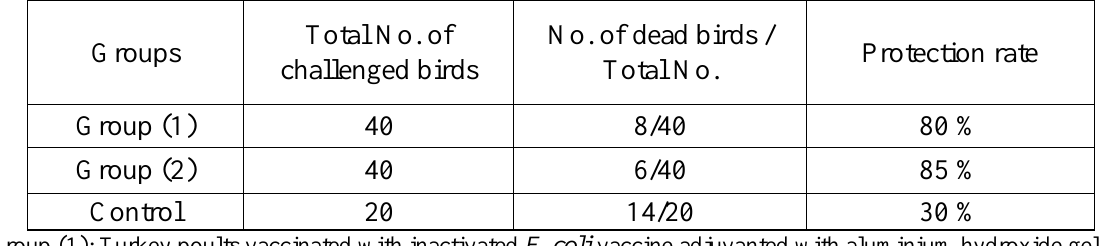
Table 5: Results of challenge test among turkey poults vaccinated with inactivated E.coli adjuvanated with aluminiumhydroxide gel and inactivated E.coli adjuvanated with montanide ISA70